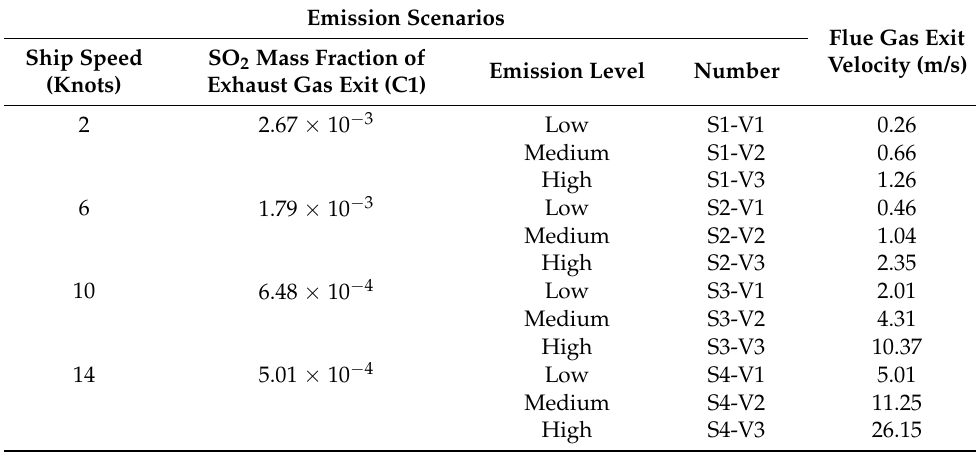
Table 2. Flue gas exit velocity for the different emission